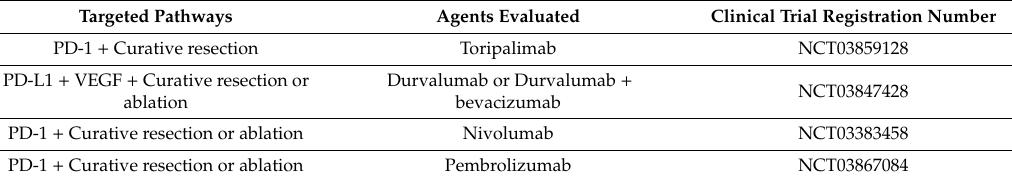
Table 4. Selective ongoing clinical trials of immunotherapy agents in the adjuvant